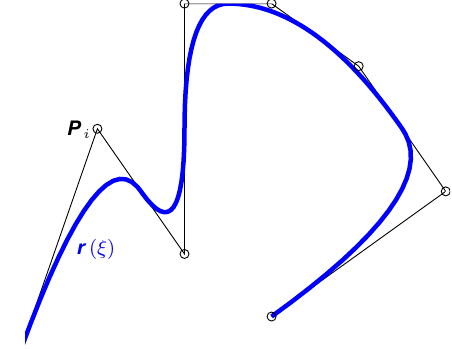
Figure 2. B-spline curve and control